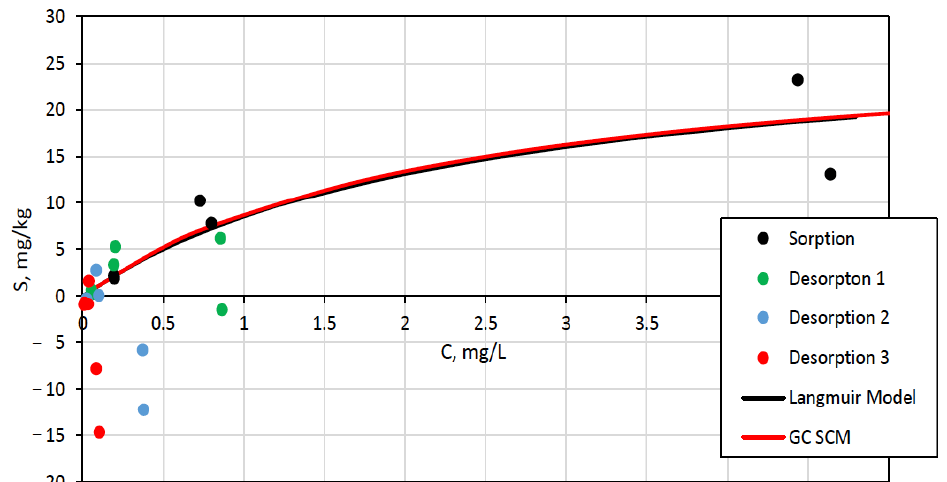
Figure 4. Sorption and desorption results for the SS-10 sandstone. Figure axes and symbols for desorption steps 1, 2, and 3 and the solid curves for GC SCM and Langmuir isotherm fits to the data are identical to those used in Figures 1–3 above. Note that the negative S values for desorption steps 2 and 3 are unrealistic and are attributed to additive experimental errors and uncertainties (see text).